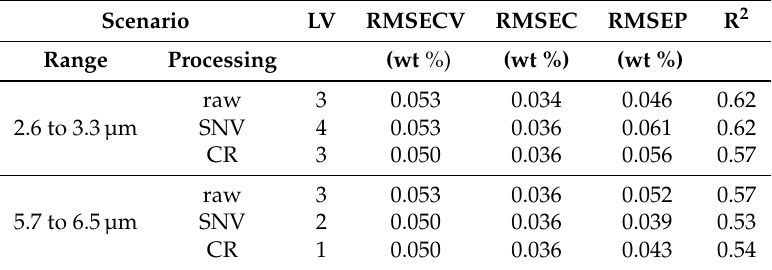
Figure 7. ( a ) Measured vs. Predicted plot of the PLS-R model for the 5.7 to 6.5µm range after SNV processing. LV = 3 in the calibration and validation samples. ( b ) Residuals plot of the PLS-R calibration. Table 3. Summary of the parameters and performance indicators of the best PLS-R calibrations, including K 2 O, Fe 2 O 3 , and MgO as